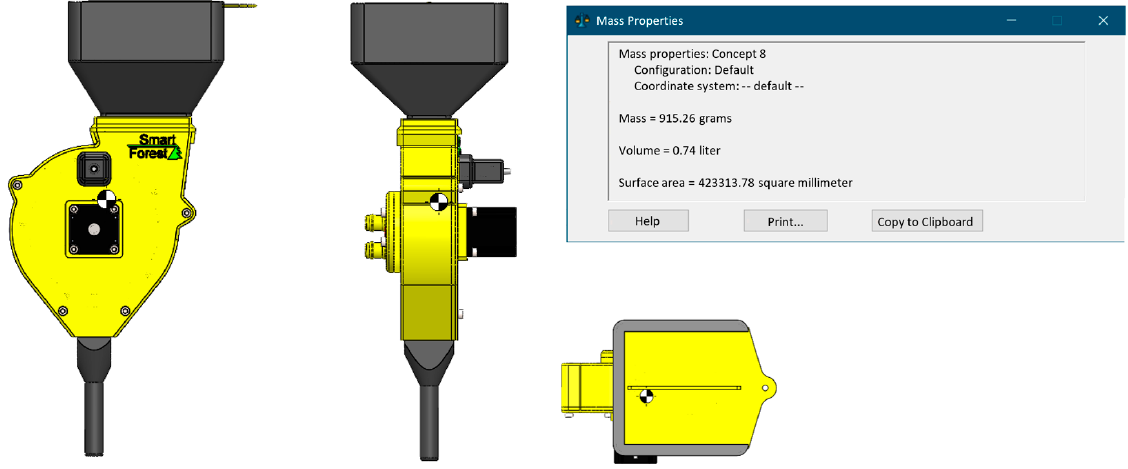
Figure 7. Investigation of mass-inertial characteristics of sowing devices.